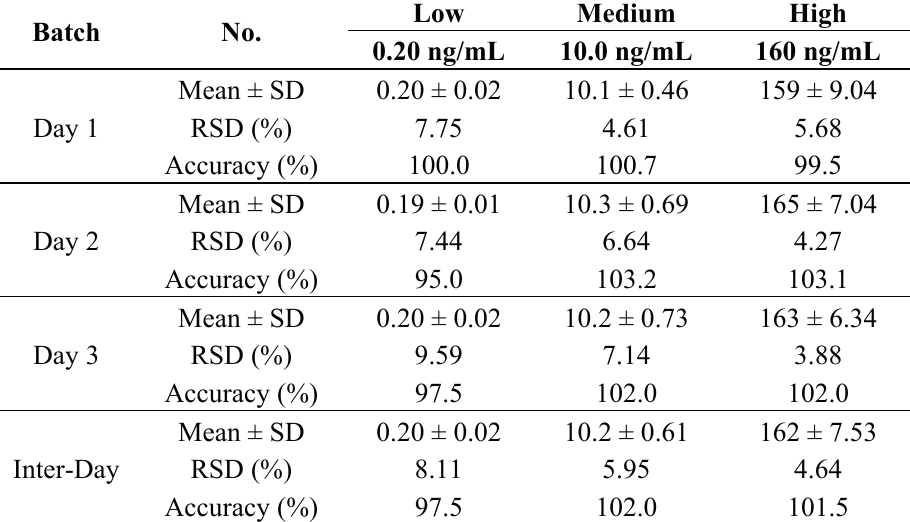
Table 2. Precision and accuracy of the assay method for PD in rat